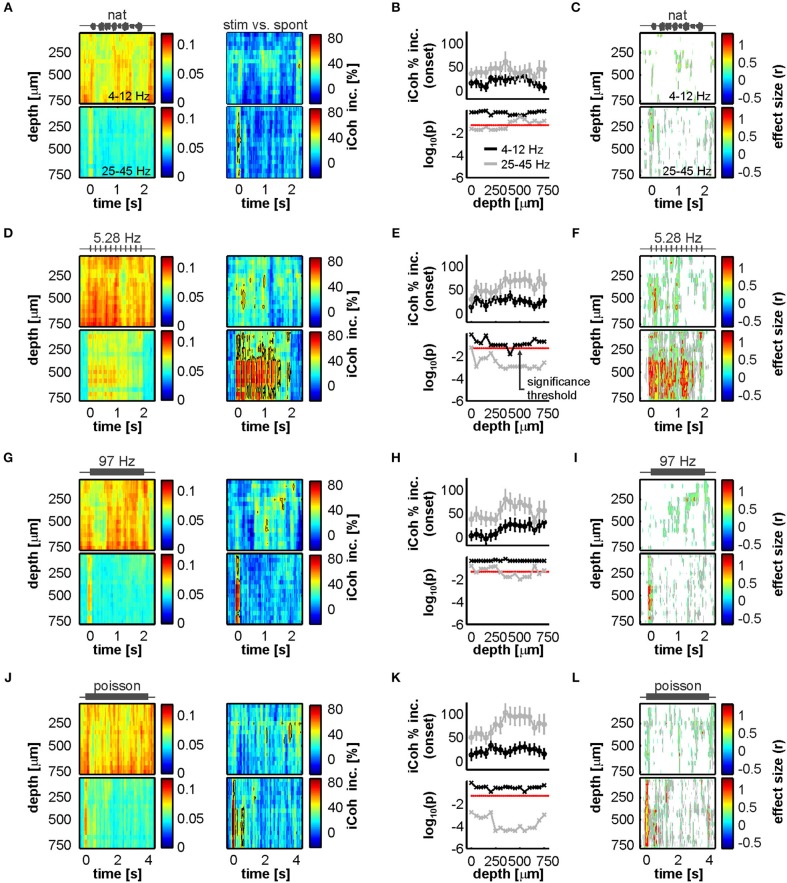
Acoustic stimulation alters FAF-AC coherence mostly in the gamma-band. (A)
Top: average time course of iCoh while animals listened to the natural sequence (left) across recording depths for low frequencies (4–12 Hz), and percentage increase of coherence in that range relative to the spontaneous activity (right). Bottom: same as Top, but for iCoh values in the gamma range (25–45 Hz). Black contour lines delimit regions with average increase of coherence >50%. (B) Population onset-related iCoh increase (median in the period of 0–100 ms after stimulus onset) across depths in the AC (black traces, low-frequency band iCoh; gray traces, gamma-band iCoh; shown as mean ± SEM). On the bottom subpanel, log-scaled corrected p-values obtained after testing that such increase was significantly different from 0% (black, low-frequency band; gray, gamma-band; FDR-corrected Wilcoxon signed rank tests, significance when pcorr < 0.05, indicated as a red dashed line). (C) Time-resolved effect size of population iCoh percentage increase (r; see Methods) for the low-frequency band (top) and the gamma-range (bottom). Gray contour lines delimit regions of r > 0.3, whereas red contours mark regions of r > 0.5 (medium and large effect sizes, respectively). r values are only shown for time points, across channels, where the coherence increase was significantly higher than 0% (Wilcoxon signed rank test, p < 0.05). (D–F) Same as (A–C) but considering a syllabic train at 5.28 Hz as stimulus. (G–I) Same as (A–C), the stimulus being a syllabic train at 97 Hz. (J–L) Same as (A–C), except the stimulus was the Poisson syllabic train.